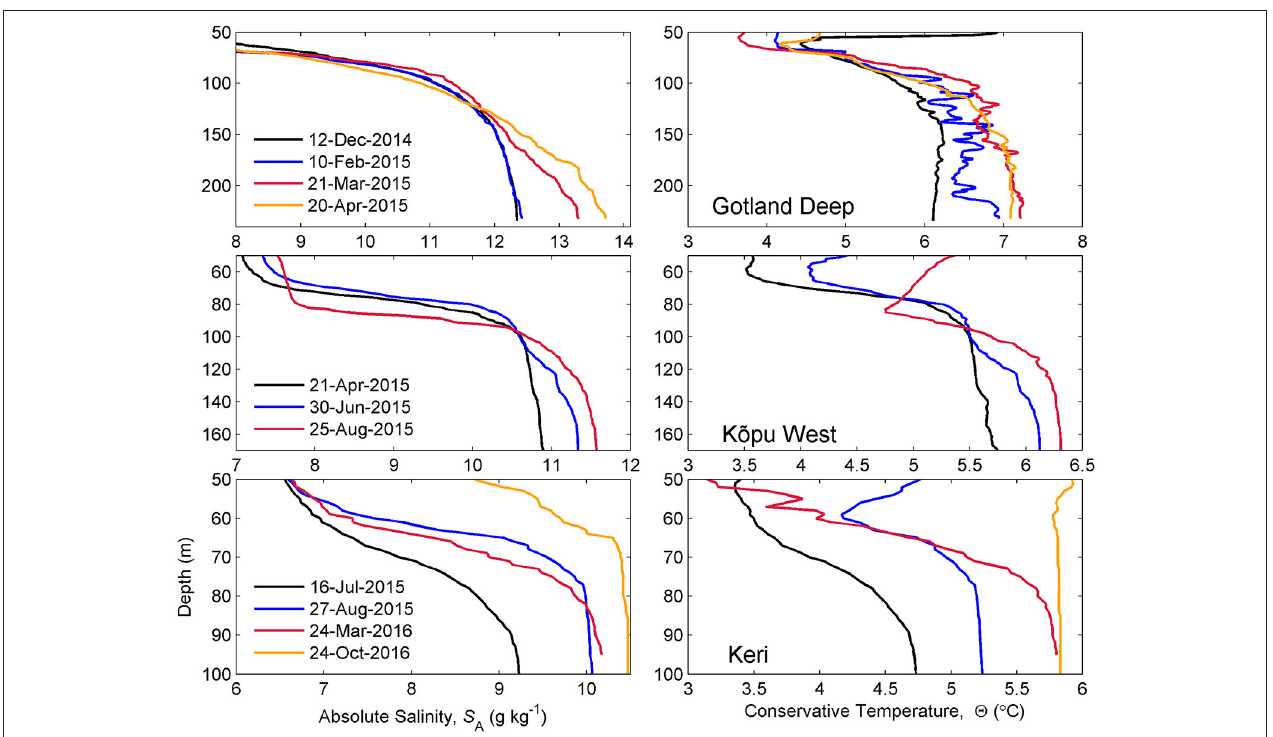
FIGURE 13 | Selected temperature and salinity profiles in the Gotland Deep, Northern Baltic Proper (Kõpu West) and the Gulf of Finland